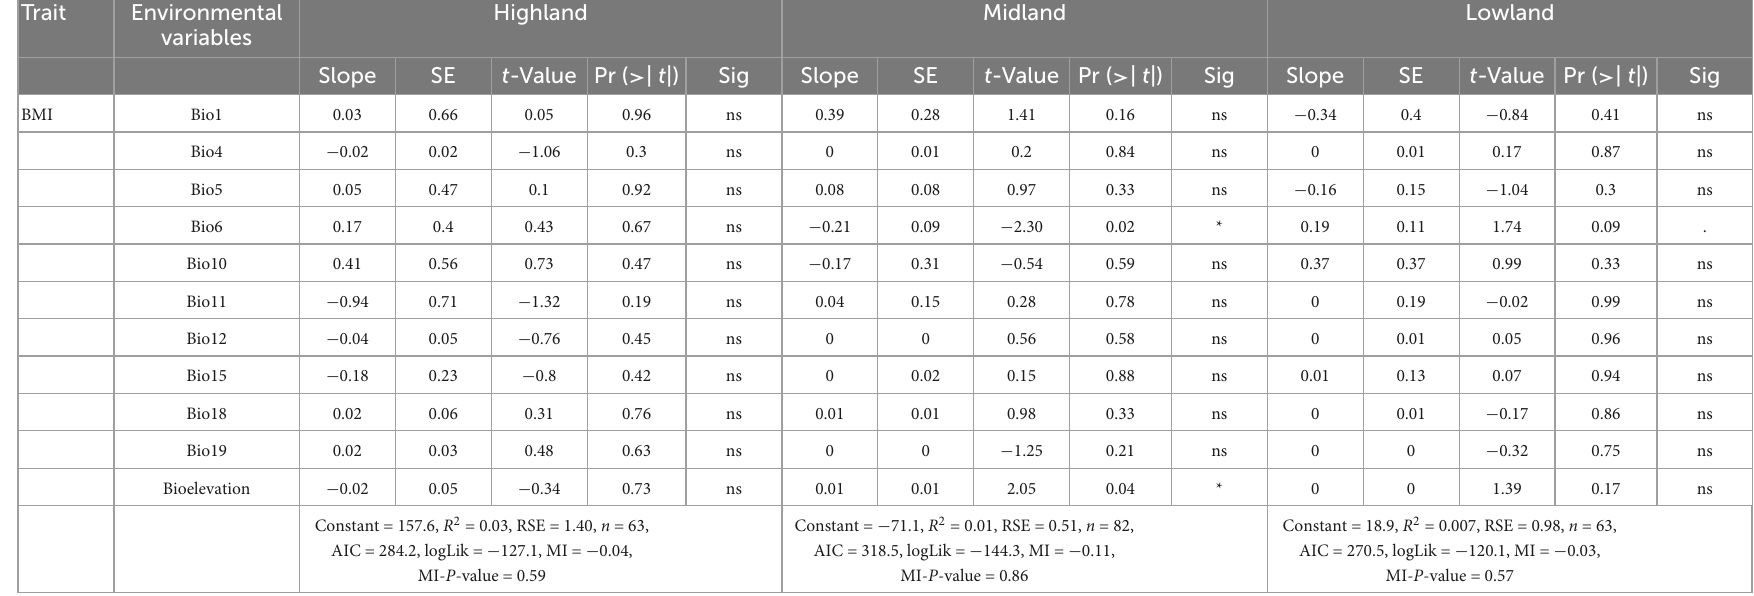
TABLE 3 Relationships (multiple linear regression) between female chicken phenotypes and environmental variables (Bergmann’s rule). Trait Environmental Highland Midland Lowland variables Slope BMI